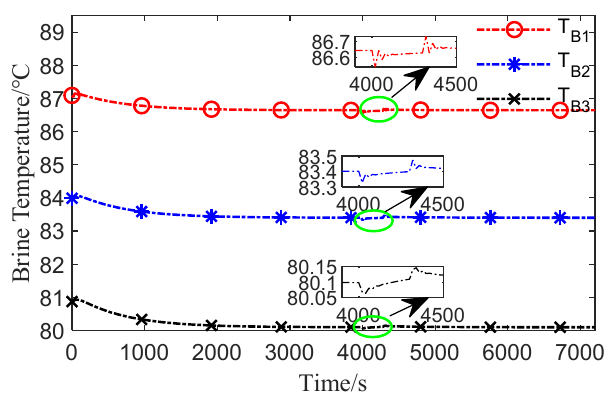
Figure 25. Dynamic of T B 1 , T B 2 , T B 3 for step increase in W Re .